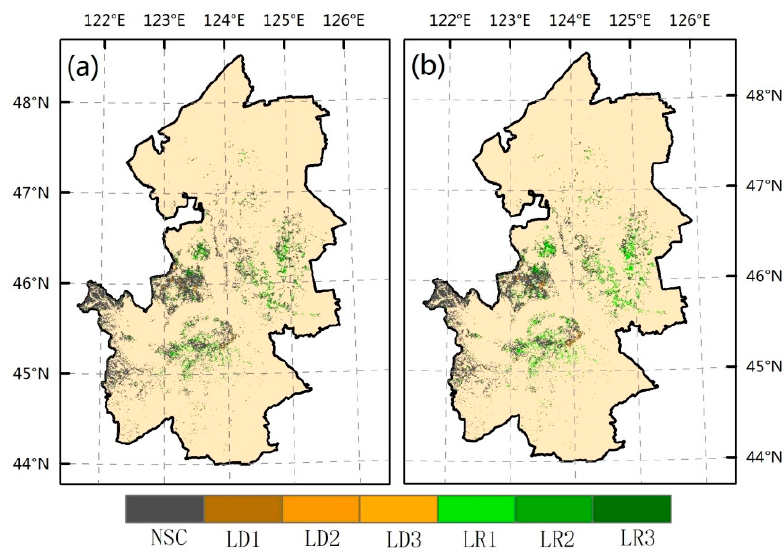
Figure 9. The trend and significance of VPR residual detected using ( a ) P-RESTREND and ( b ) RESTREND. The significance classes for land recovery are as follows: LR1 (P < 0.01), LR2 (0.01 < P < 0.05), and LR3 (0.05 < P < 0.1). The significance classes for land degradation are as follows: LD1 (P < 0.01), LD2 (0.01 < P < 0.05), and LD3 (0.05 < P < 0.1). No significant change is NSC (P > 0.1).